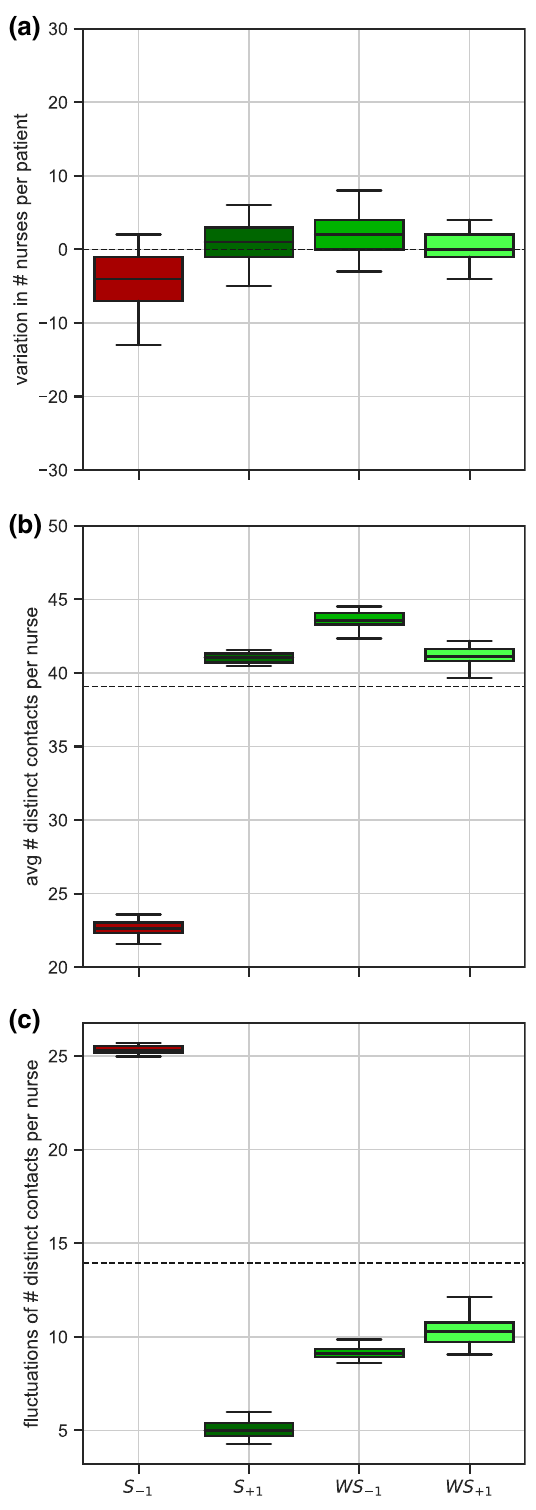
Figure 7. Effect of reorganization on contact patterns. ( a ) Variation of the number of distinct nurses assigned to each patient, in the reorganized vs. empirical contact pattern. ( b ) Average number of distinct contacts per nurse (nurses’ degree). Dashed line corresponds to the empirical value. ( c ) Fluctuations (standard deviation) of the number of distinct contacts per nurse. Dashed line corresponds to the empirical value. For ( a – c ), results are obtained from 500 random